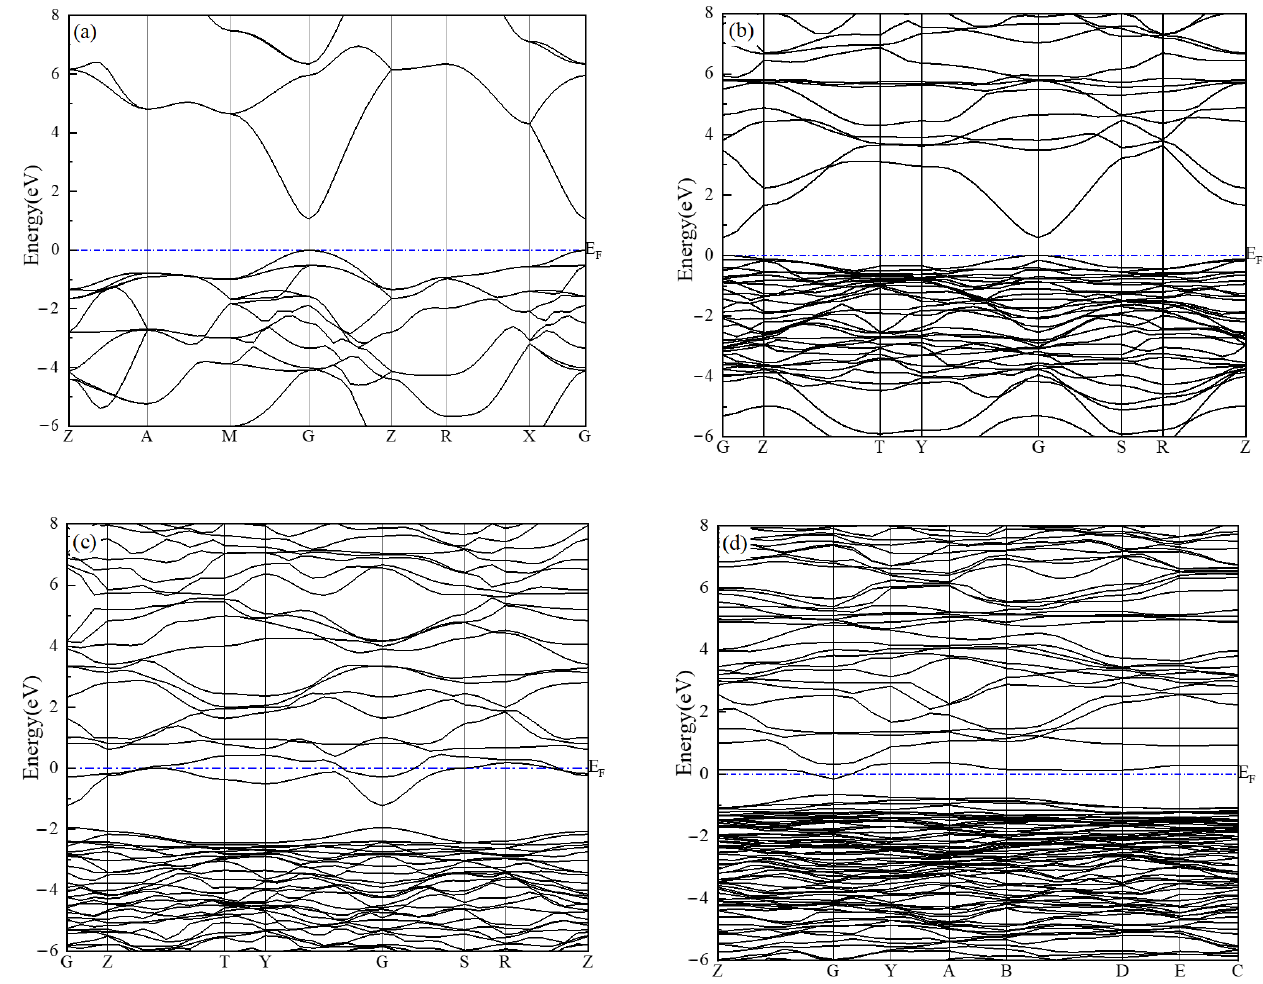
Figure 2. Band structure: ( a ) SnO 2 ; ( b ) Y-doped SnO 2 ; ( c ) Mo-doped SnO 2 ; ( d ) Y-Mo co-doped SnO 2 .